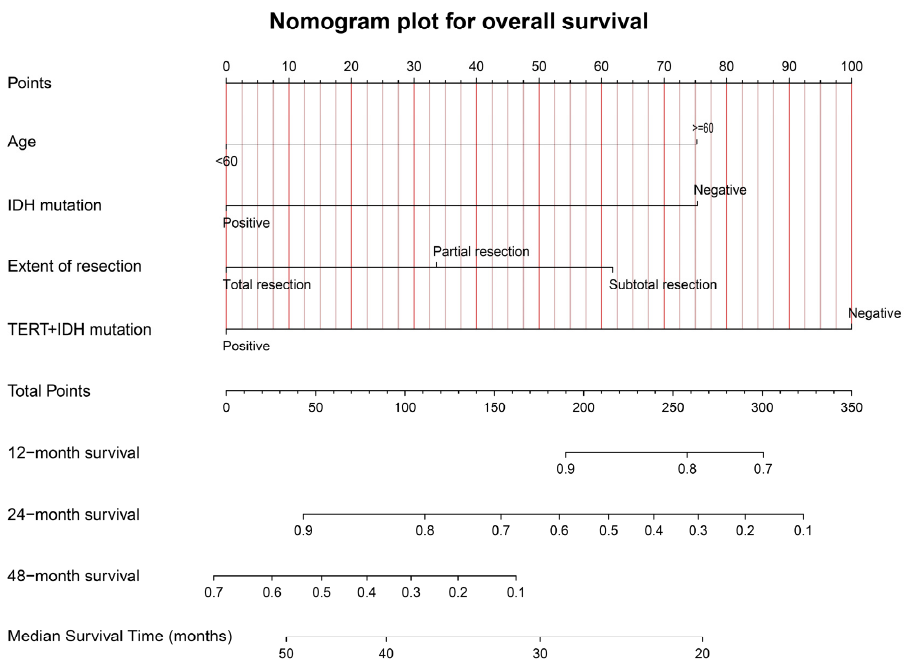
Figure 6. The graphical nomogram model for OS based on the four significant predictors. The model could provide the predicted survival rates at 12, 24, and 48 months, and the median survival time.